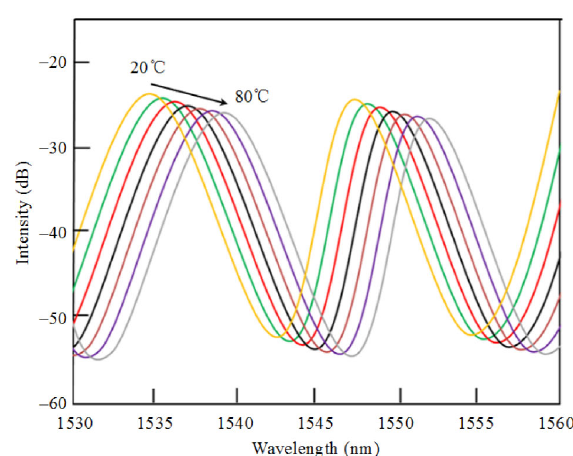
Fig. 5 Spectra evolution of the MZI-based sensor with different temperatures from 20 ℃ to 80 ℃ , per–10 ℃ (polynomial